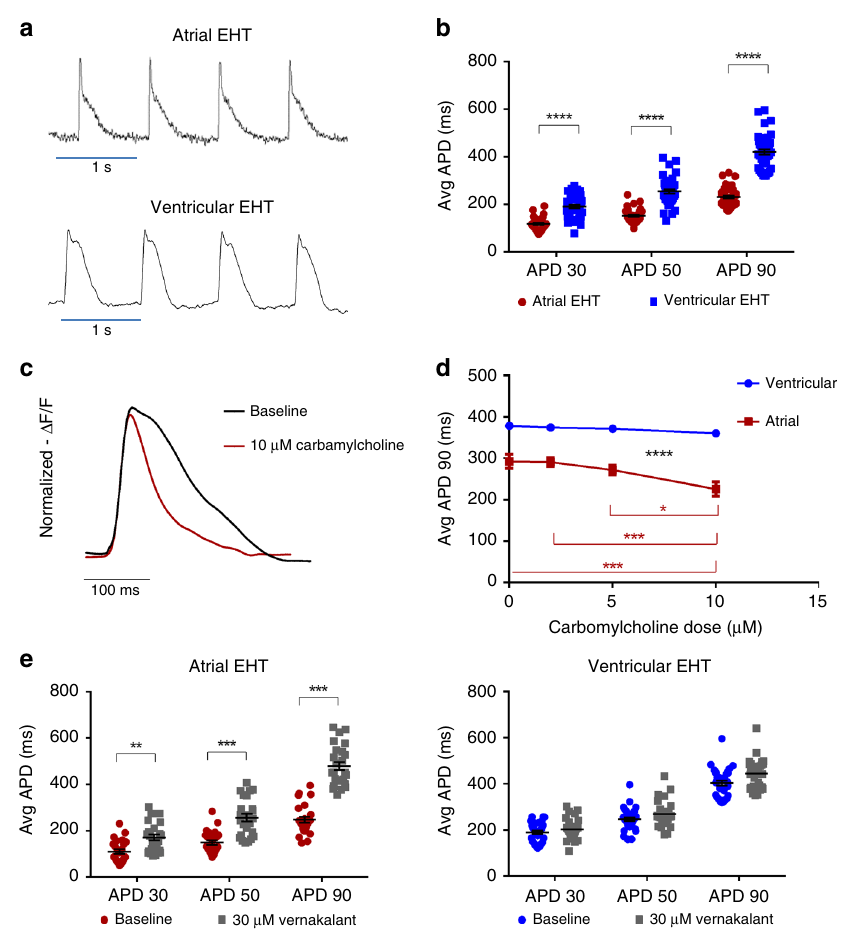
Fig. 3 Electrophysiological characterization of the chamber-speci fi c EHTs. a Confocal line-scan images showing examples of optical AP recordings of atrial and ventricular cells within the chamber-speci fi c EHTs. b Comparison of mean APD 30 , APD 50 , and APD 90 values in the atrial and ventricular EHTs ( n = 46 and n = 42 cells, respectively, from three independent experiments) during 1 Hz fi eld stimulation. **** p < 0.0001, unpaired t test. c , d Changes in AP morphology ( c ) and duration (APD 90 ) ( d ) following application of increasing doses (0, 2, 5, 10 µ M) of carbamylcholine and 1.5 Hz fi eld stimulation in the chamber-speci fi c EHTs. Note that signi fi cant AP shortening was observed in the atrial (* p < 0.05, *** p < 0.001), but not in the ventricular EHTs ( p = NS, repeated-measurements two-way ANOVA followed by Sidak post hoc analysis, n = 19 cells from three independent experiments for both the atrial and ventricular experiments). e Changes in mean APD 30 , APD 50 , and APD 90 values following application of 30 µ M verankalant during 1.5 Hz fi eld